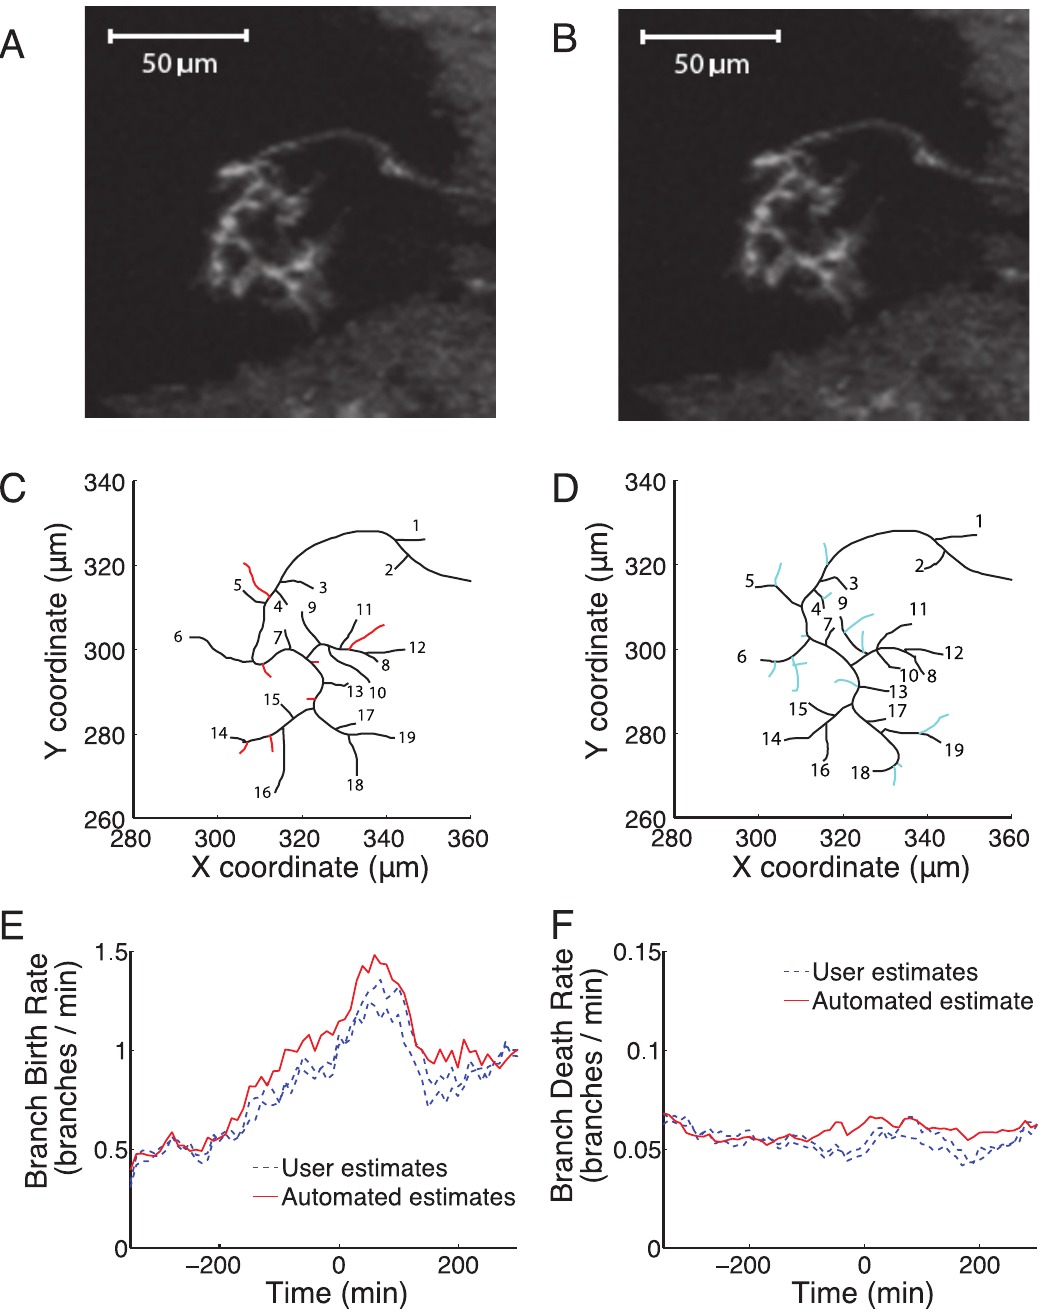
Fig 2. Branch matching using DTW identified branches that were removed, added or maintained between consecutive frames 10 minutes apart. (A) & (B): The original images of a control axon in two consecutive frames. (C): Seven branches (red) were removed completely or “ died ” between the two frames. (D): Thirteen new branches (cyan) were added or “ born ” in the ten minutes between the frames. Nineteen branches (numbered in both A and B) survived the interval (black), though they could have extended, retracted or shifted. (E): The branch birth rate for the DTW identified branches (automated, red line) was similar to that of two human users (dashed blue lines) who manually identified branches in one movie. (F): The death rate was comparable for branches either identified by DTW (automated, red line) or manually by two human users (dashed blue lines).